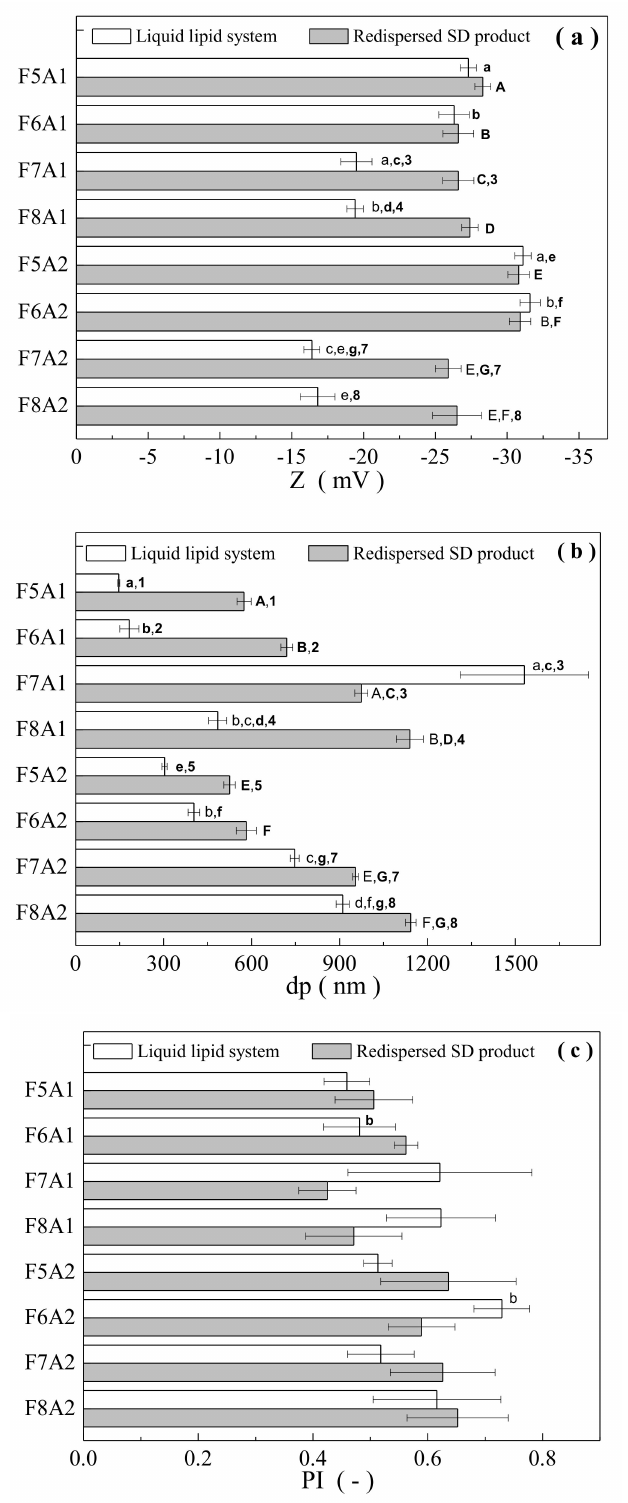
Figure 1. Comparison between the experimental results of zeta potential (Z), emulsion size (dp), and polydispersity index (PI) of the liquid and redispersed dried lipid systems, ( a – c ), respectively. Same letters / numbers indicate a statistically significant di ff erence (Tukey’s post-test, p ≤ 0.05). Concerning the drying carriers’ systems, there are significant di ff erences between the zeta potential determined for both systems (coded as A1 and A2). For NLCs containing oleic acid, a slight increase